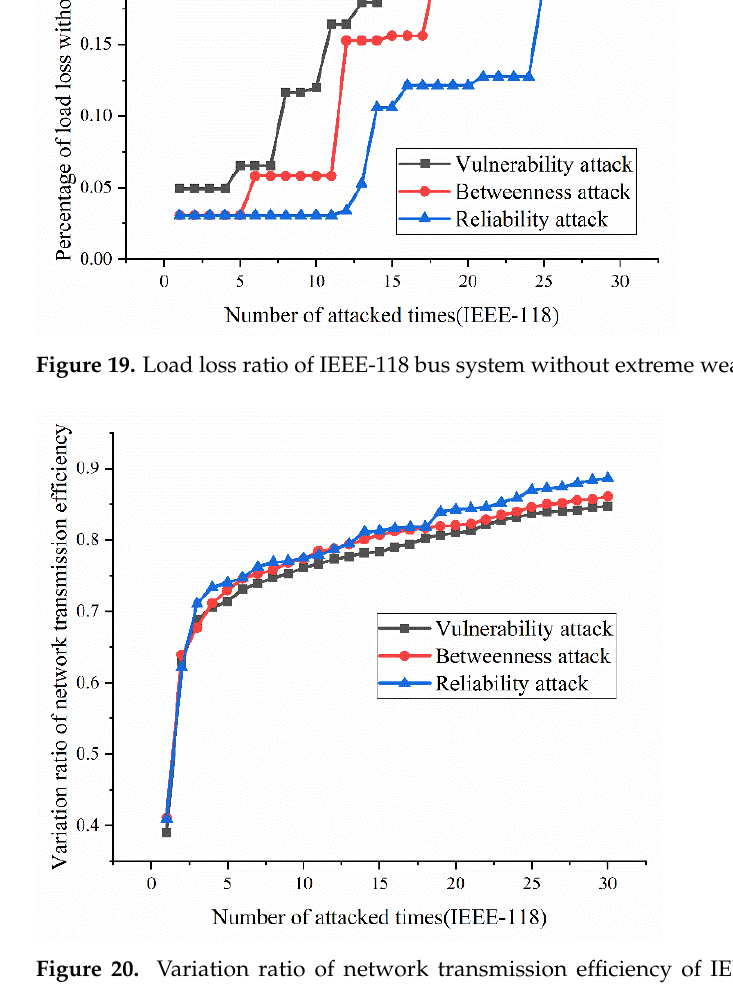
Figure 20. Variation ratio of network transmission efficiency of IEEE-118 bus system without extreme weather.